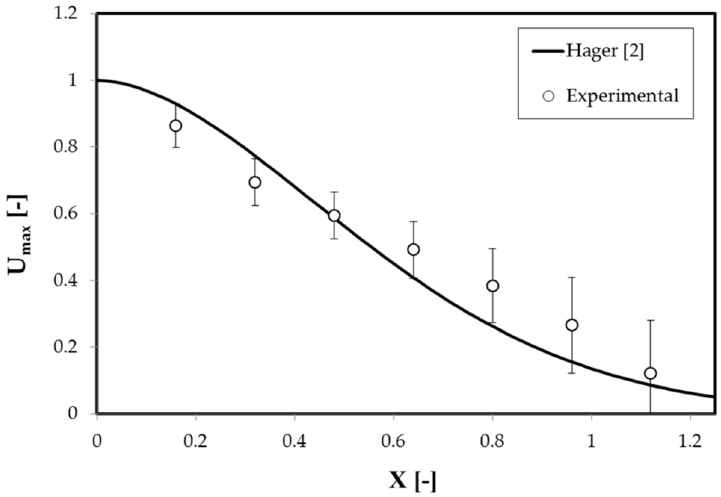
Figure 8. Maximum forward velocity decay along the hydraulic jump longitudinal axis.